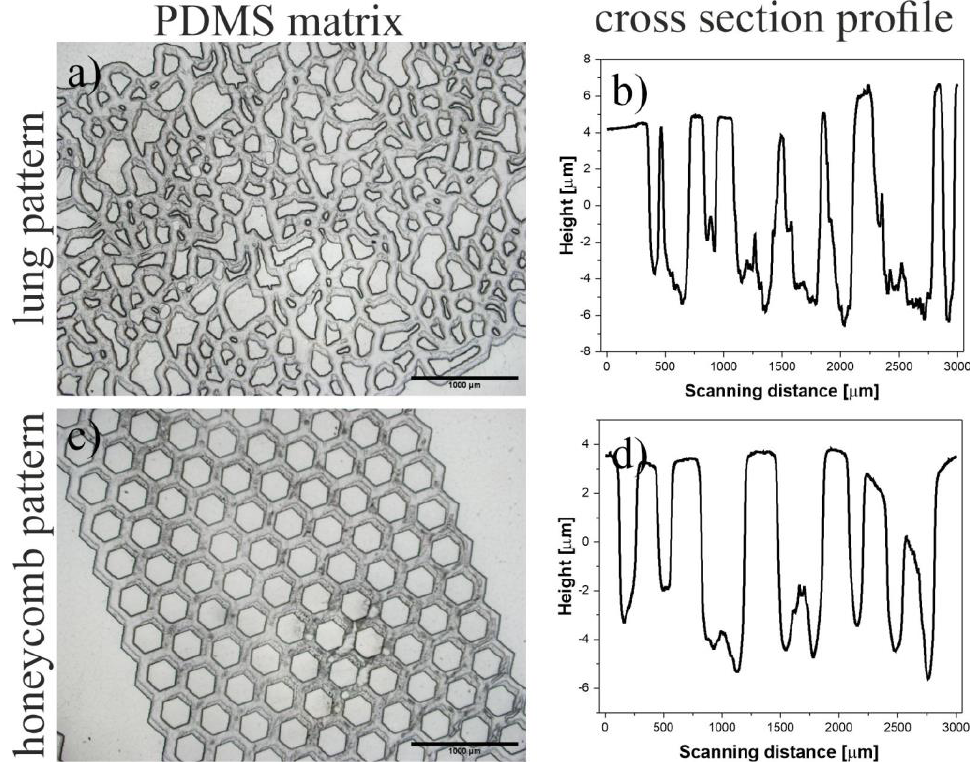
Figure 6. ( a , b ) Isotropic and ( c , d ) honeycomb masters used to fabricate 3D structures by PDMS molding.